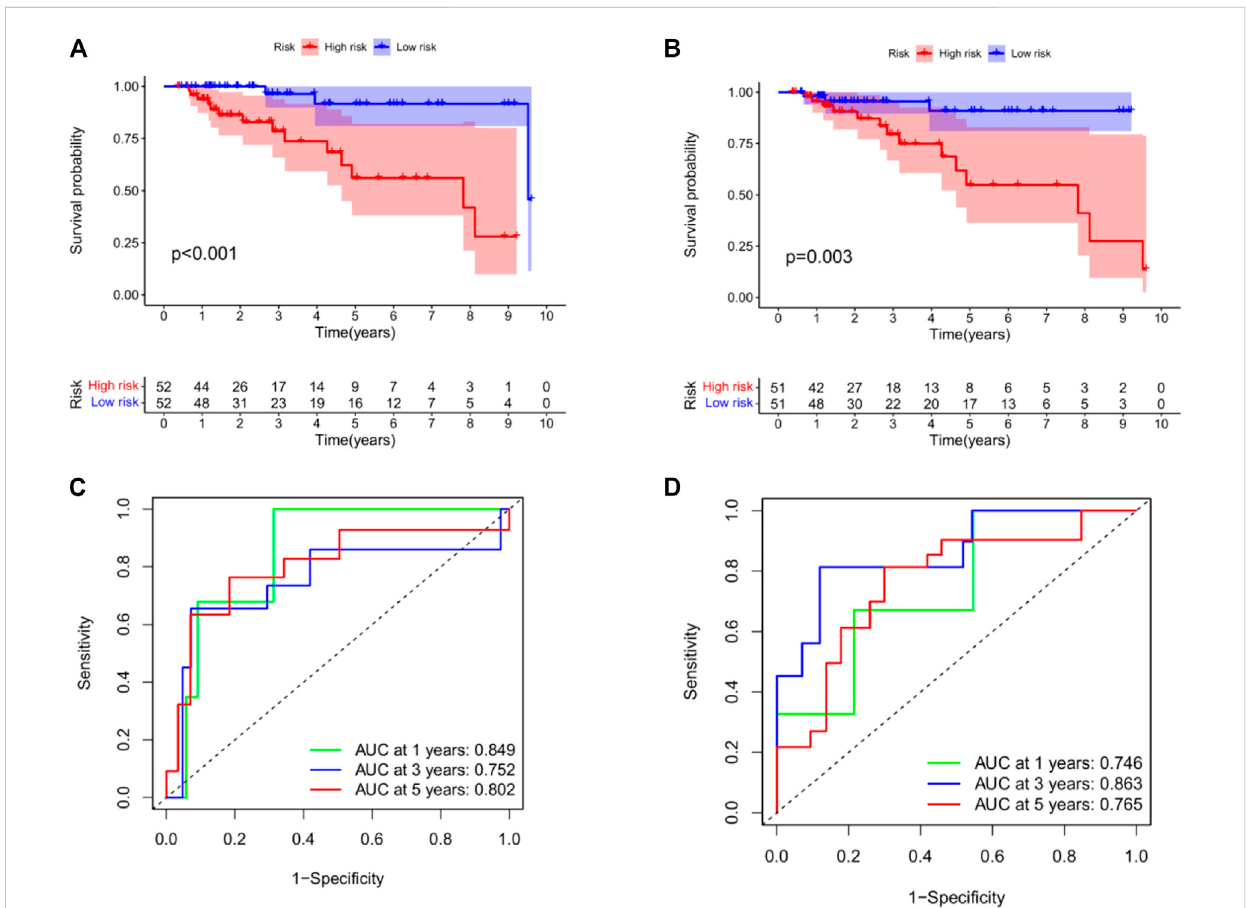
FIGURE 7 Construction of prognostic model in the training datasets. (A) KM curves for the OS of patients in the high- and low-risk groups in the 2 mRNAs- related prognostic model. (B) KM curves for the OS of patients in the high- and low-risk groups in the 2 miRNAs-related prognostic model. (C) Time- dependent ROC curve analysis of the 2 mRNAs-related prognostic for predicting 1-, 3-, 5-year OS. (D) Time-dependent ROC curve analysis of the 2 miRNAs-related prognostic for predicting 1-, 3-, 5-year OS. In addition, we used GSE42568 to validate survival in the high - and low-risk groups (see the Supplementary Figure S1 in Supplementary